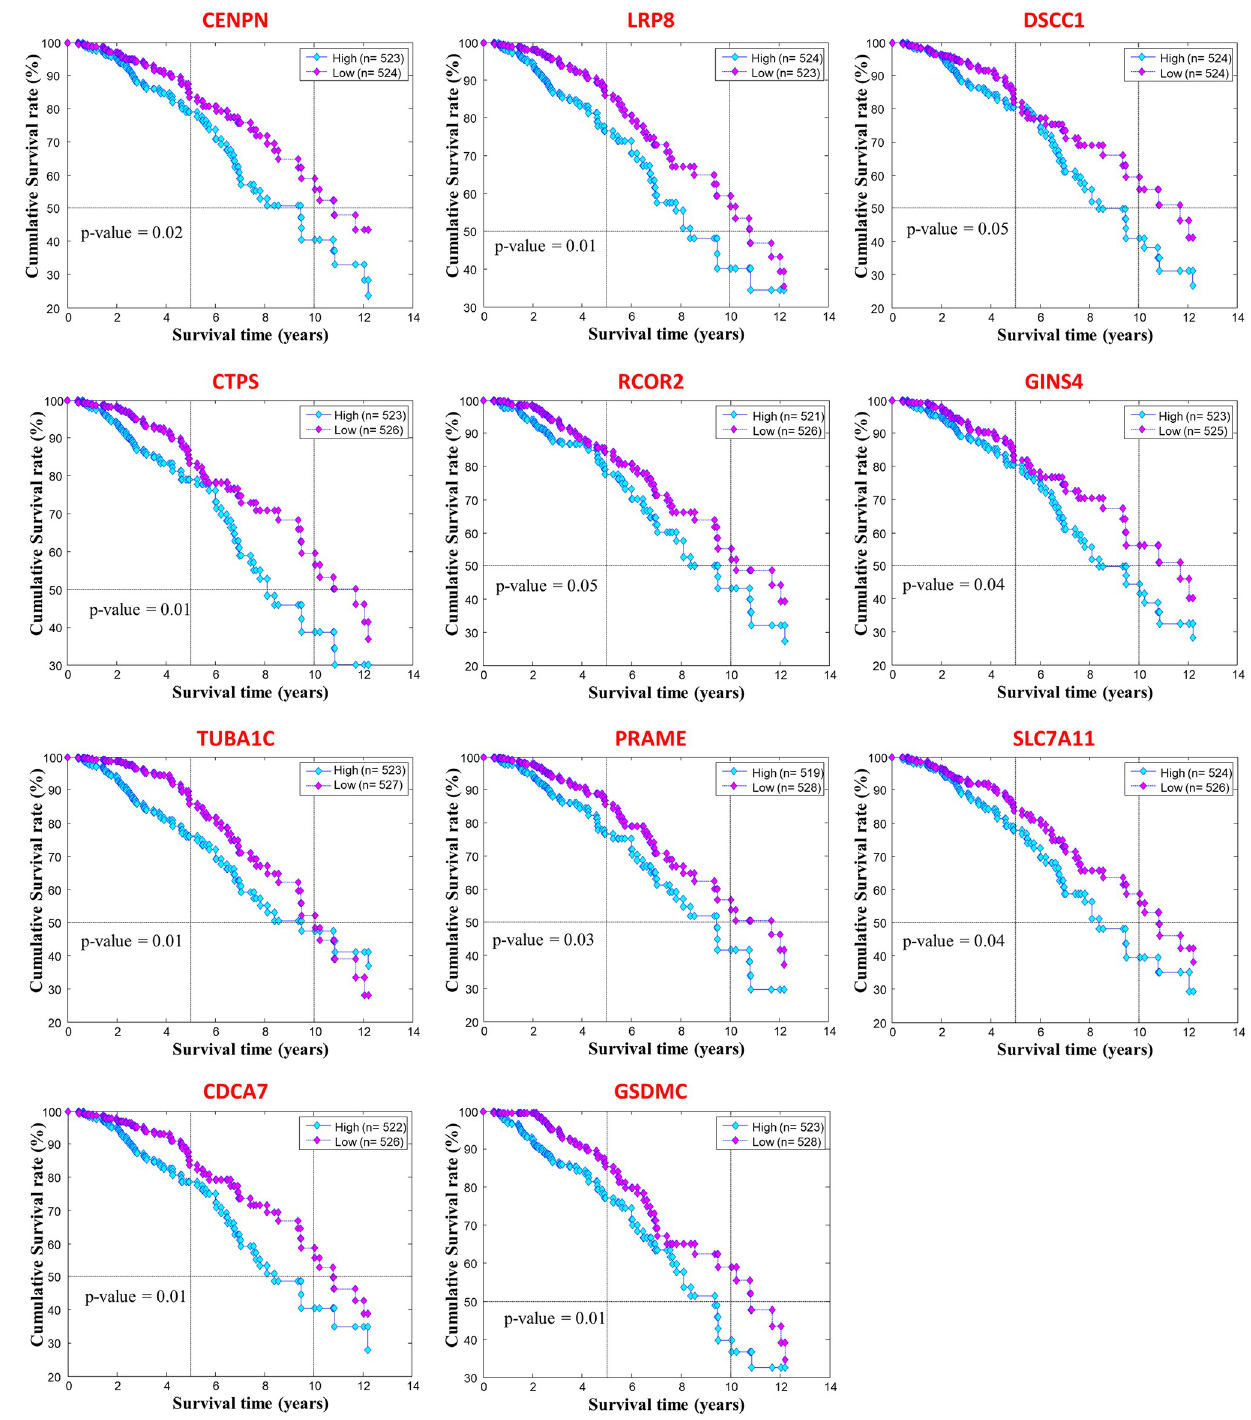
Fig 2. Switch genes with an unfavourable prognostic value from the survival analysis on TCGA data. Kaplan-Meier analyzes to evaluate the correlations between the expression of the basal-like specific switch genes and the OS in TCGA breast invasive carcinoma patients. Low- and high- expression groups refer to patients with expression levels lower and greater than the 50th percentile,